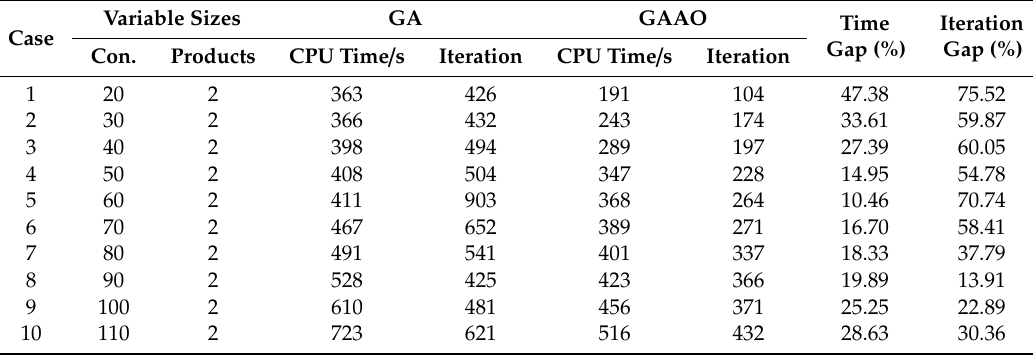
Table 3. Numerical results of medium to large-scale cases.